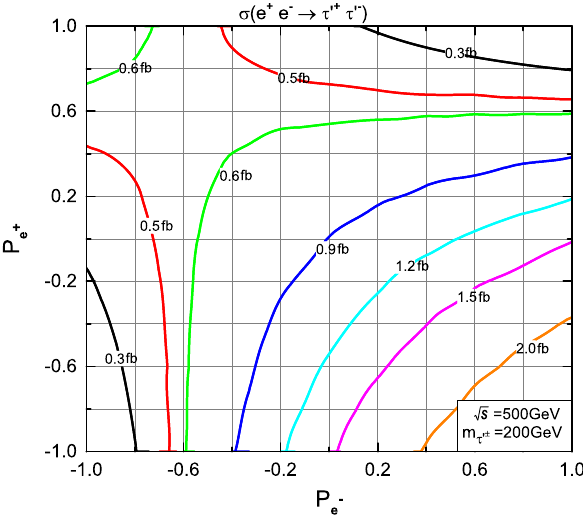
Fig. 2 Polarized cross sections of e − e + → τ (cid:2) − τ (cid:2) + at different polar- ization P e − and P e + for m τ (cid:2)± = 200 GeV and contour lines stand for these cross sections and their unit is fb